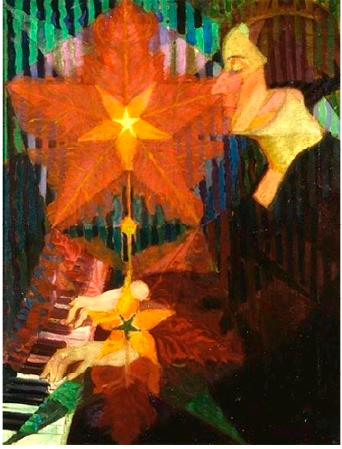
Figure 10. Frederick John de St. Vrain Schwankovsky, Modern Music , 1920, Oil on canvas, 66 × 51 cm, Laguna Art Museum, Laguna Beach, California.